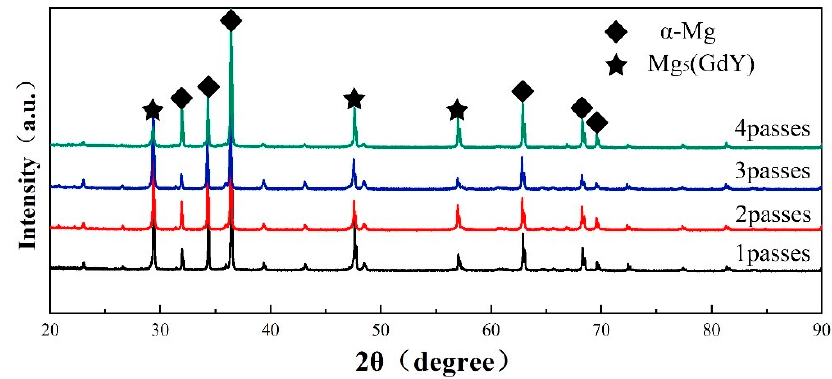
Figure 5. XRD patterns of alloys under different passes.